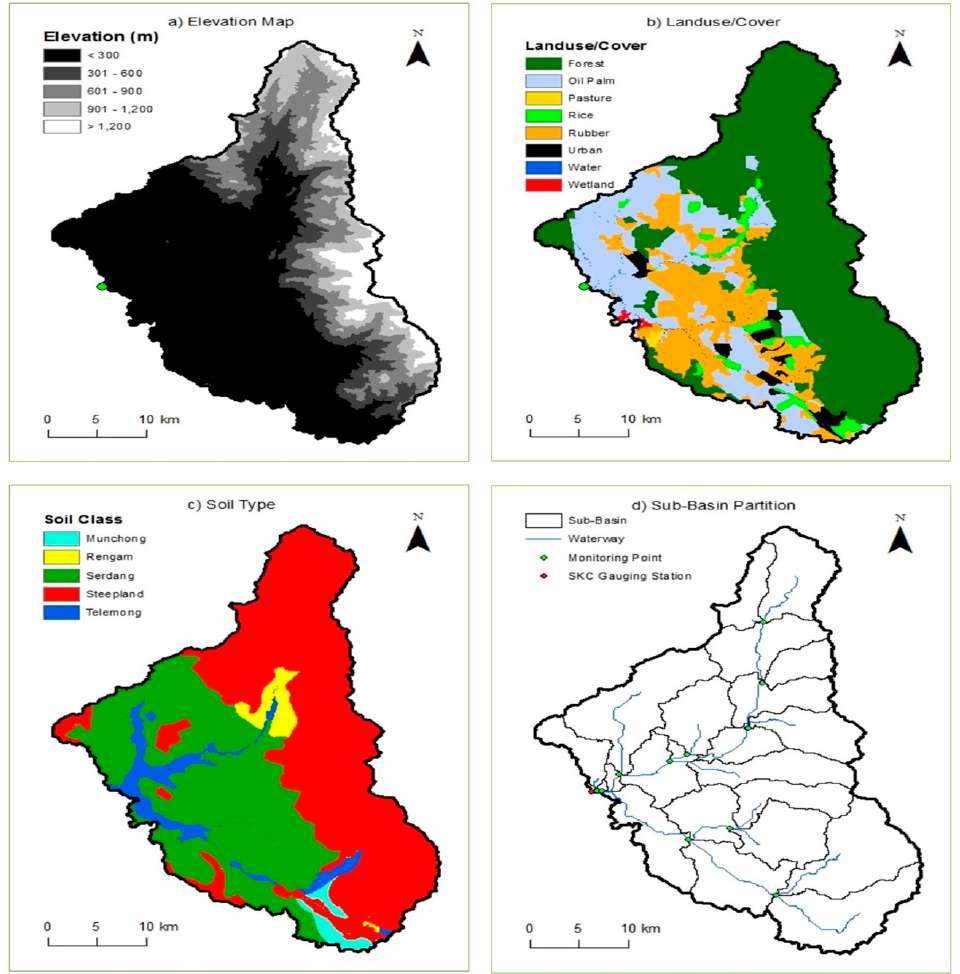
Figure 4. Spatial input data in the SWAT model for Bernam River Basin, including: ( a ) Digital Elevation Model (DEM) at 30-m resolution; ( b ) reclassified land use dataset; ( c ) soils dataset from DOA; ( d ) sub-basins’ partition.